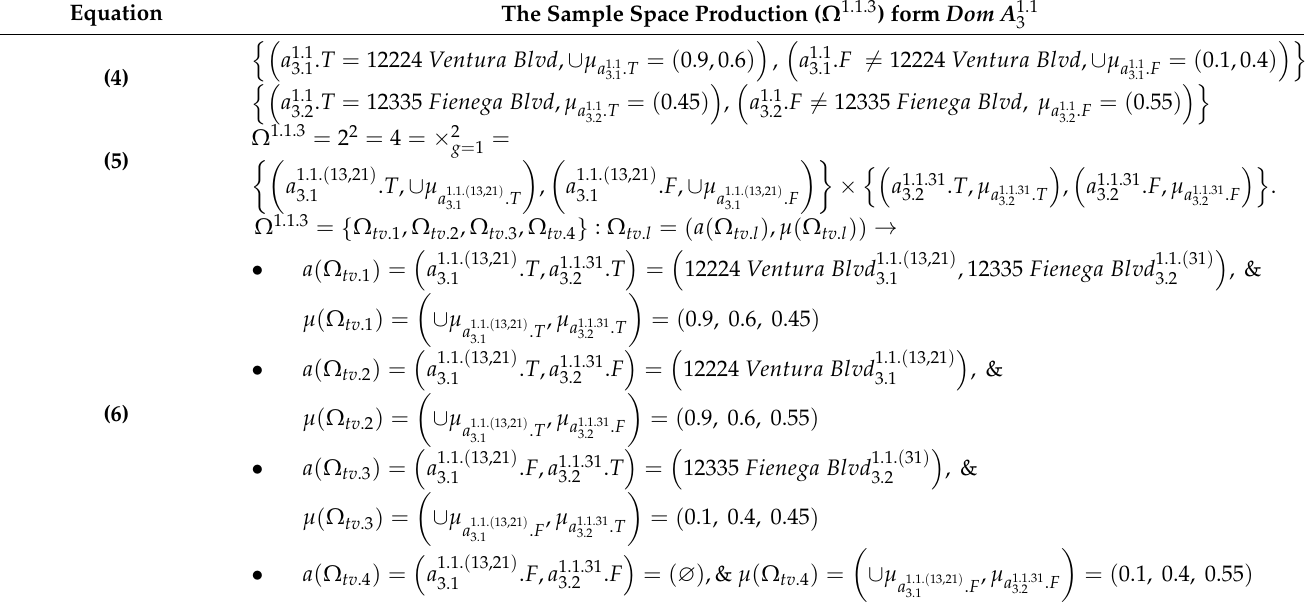
Table 3. An example for sample space